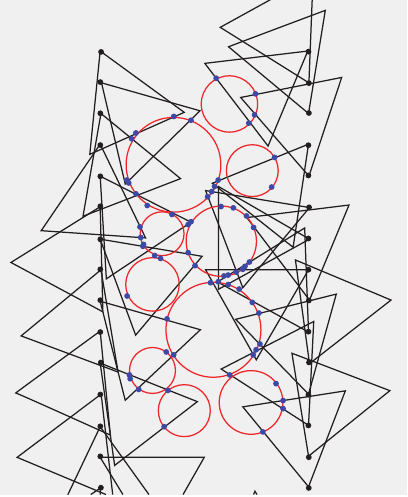
Figure 7: Example of sensors deployment. The ETV in this example is 51.52